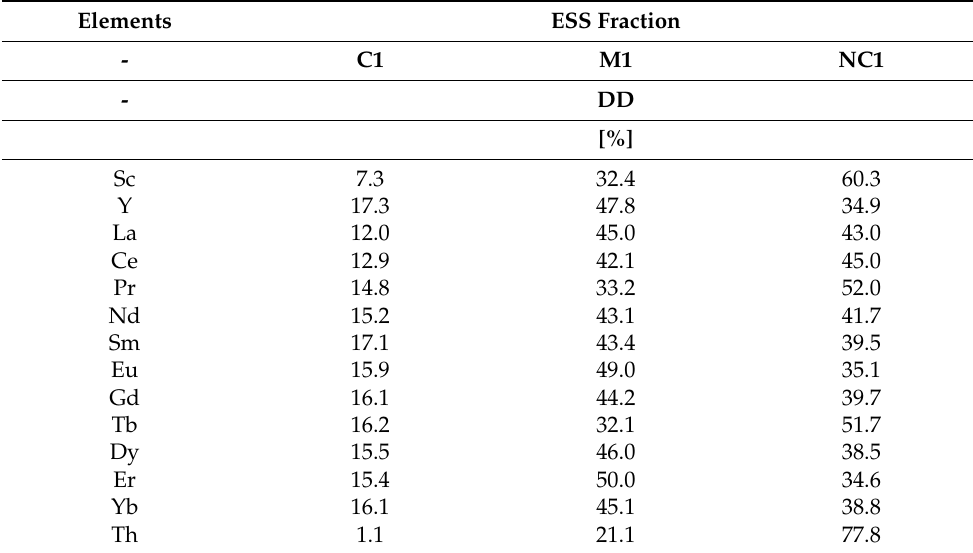
Table 11. Distribution of elements from the group of REEs.